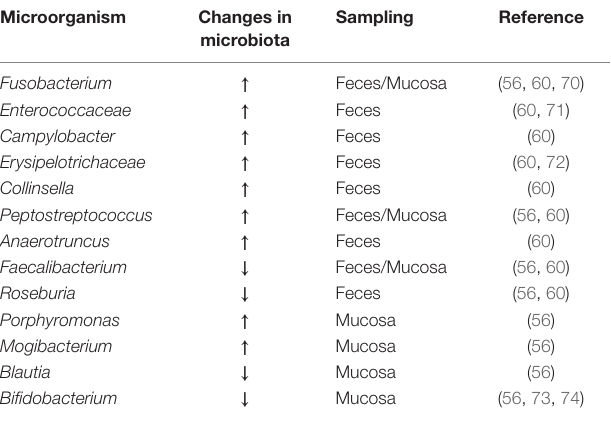
TABLe 1 | Gut bacteria associated with dysbiosis in CRC.